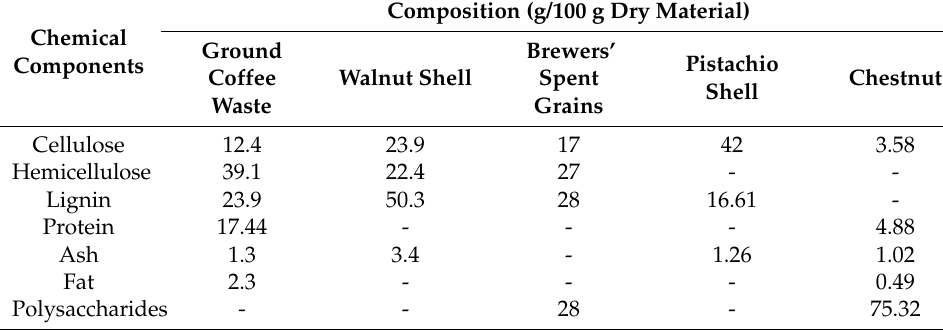
Table 2. Chemical composition of the fillers [10,23–26].